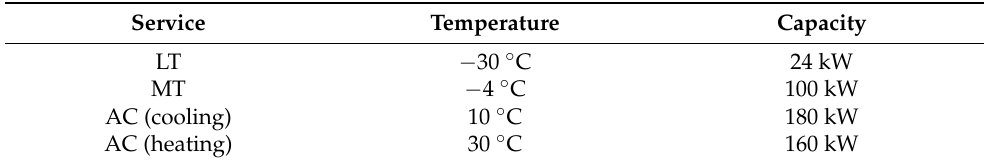
Table 2. Dimensioning temperatures and capacities for the integrated CO 2 refrigeration unit in Porto de